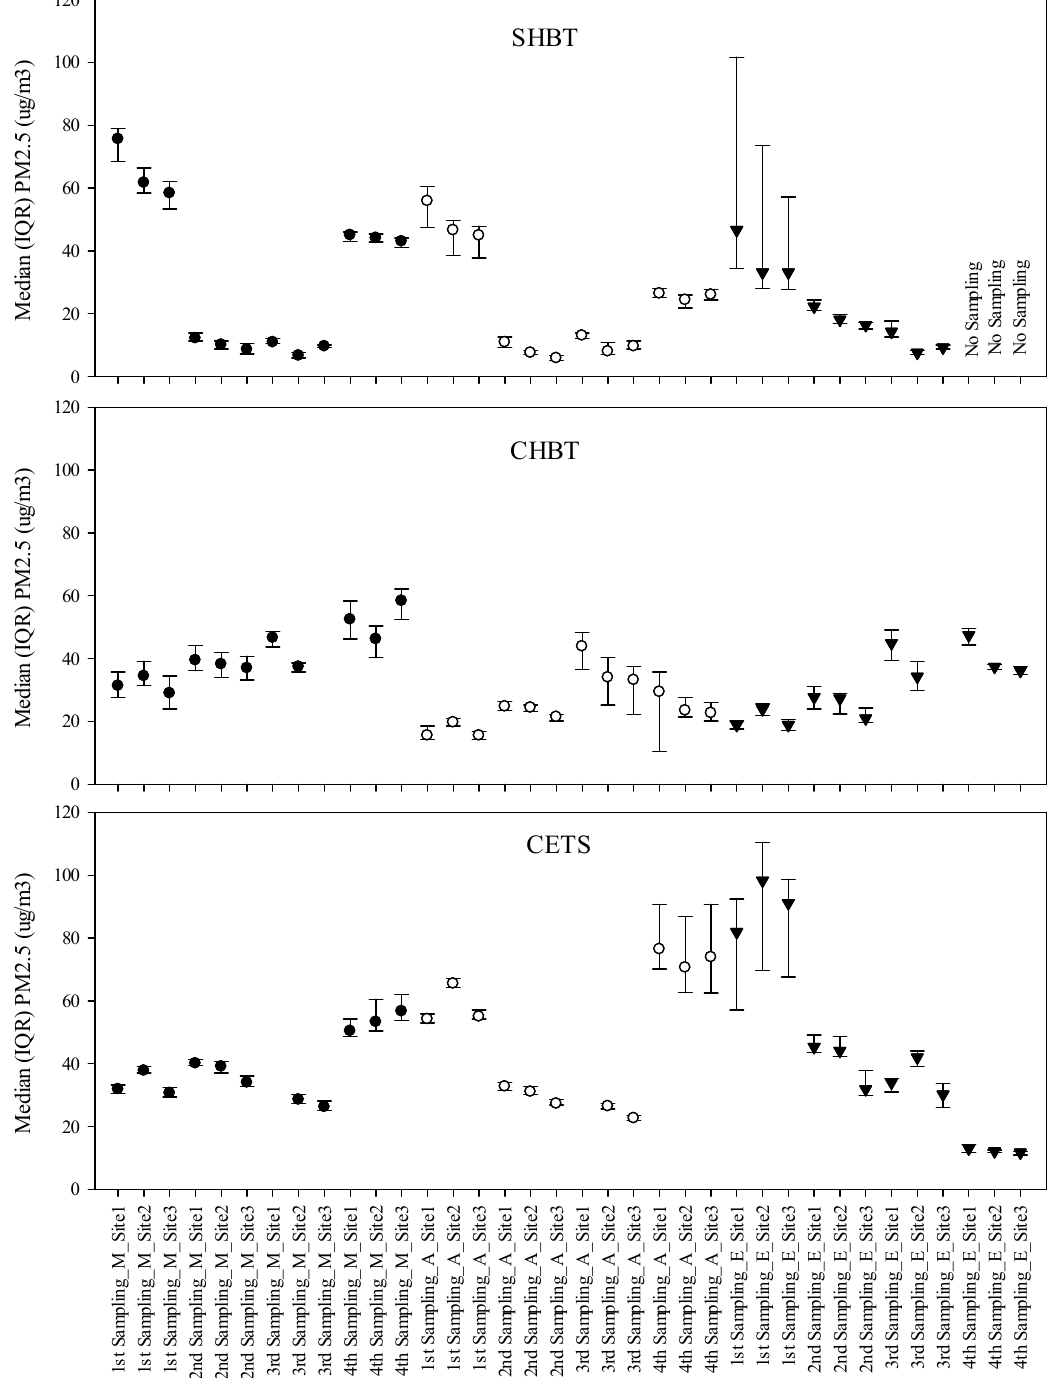
Figure A1. Distributions of PM 2.5 concentrations (Median (IQR)) of simultaneous measurement for three sites according to sampling place (SHBT, CHBT, CETS), sampling day (1st to 4th trial) and sampling time (Morning, Afternoon, Evening).